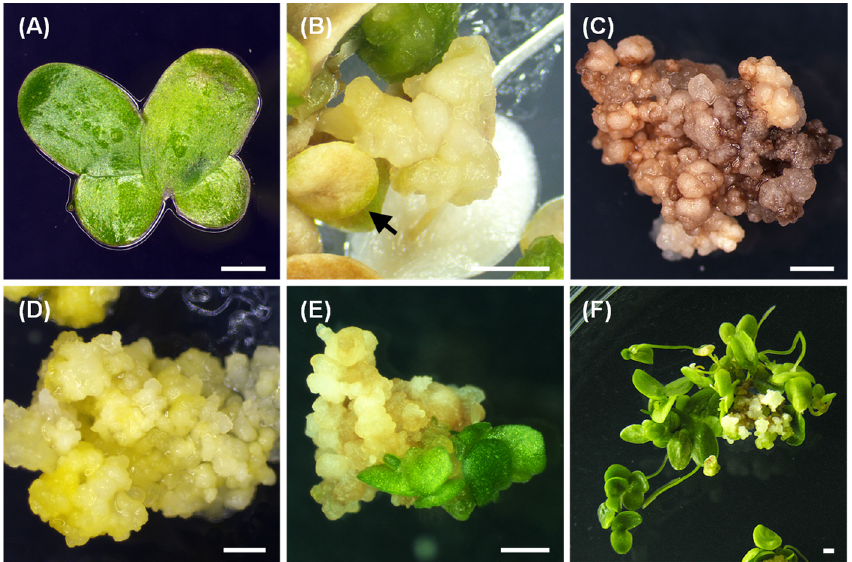
Figure 1. Lemna aequinoctialis . ( A ) Fronds of L. aequinoctialis ; ( B ) fronds were cultured for 8 weeks on MS medium containing 3% sucrose, 25 μ M 2,4-D, and 2.0 μ M TDZ to induce callus formation. The arrow indicates the senescent frond; ( C ) browning phenomenon of callus cultured on previous CIM; ( D ) callus that was separated from the bleached frond explant and grown for an additional 4 weeks on MS medium containing 3% sucrose, 4.5 μ M 2,4-D, and 2.0 μ M TDZ for callus proliferation; ( E , F ) plants regenerating from callus incubated for 2 ( E ) and 4 ( F ) weeks on SH medium containing 1% sucrose and 1.0 μ M 6-BA. Bar = 1.0 mm.